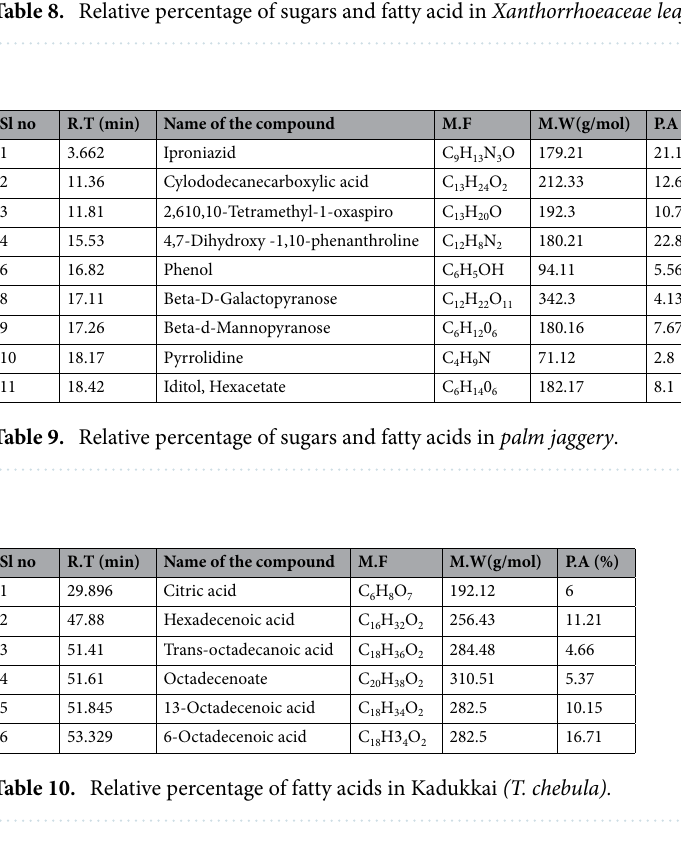
Table 8. Relative percentage of sugars and fatty acid in Xanthorrhoeaceae leaf (aloevera).